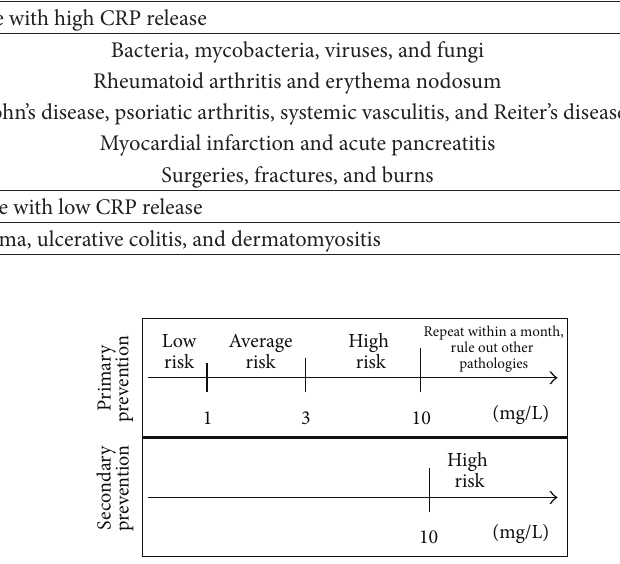
Figure 1: Use of high-sensitivity CRP levels for the stratification of cardiovascular risk (primary prevention) and as a prognostic factor in acute coronary syndrome (secondary prevention) [69,